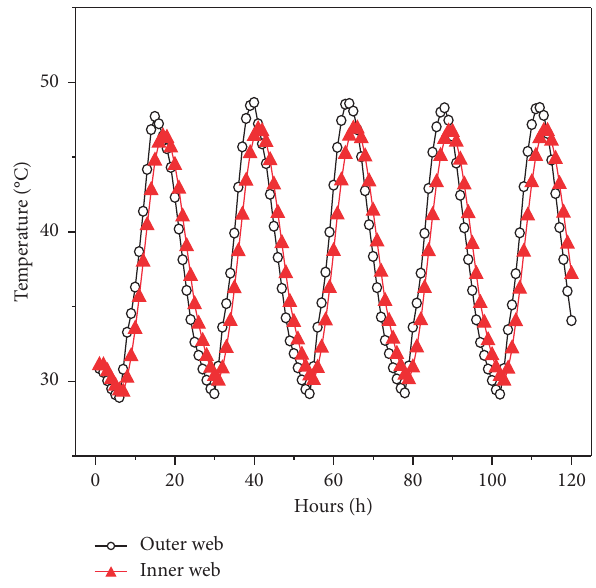
Figure 12: Comparison of variation of temperature between inner and outer